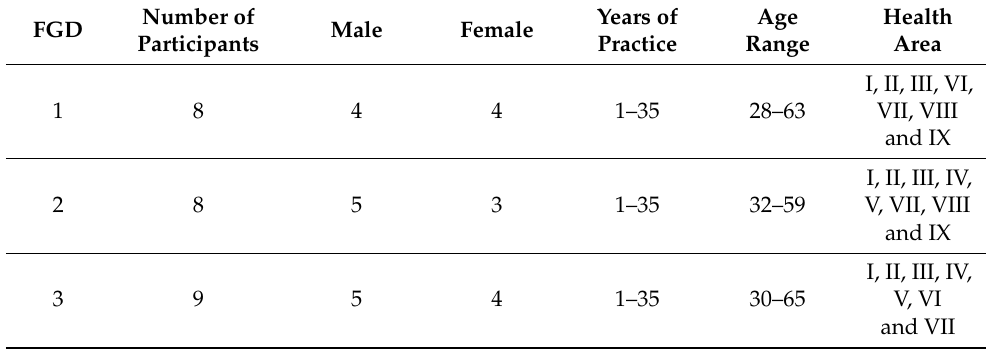
Table 1. Respondents’ demographic